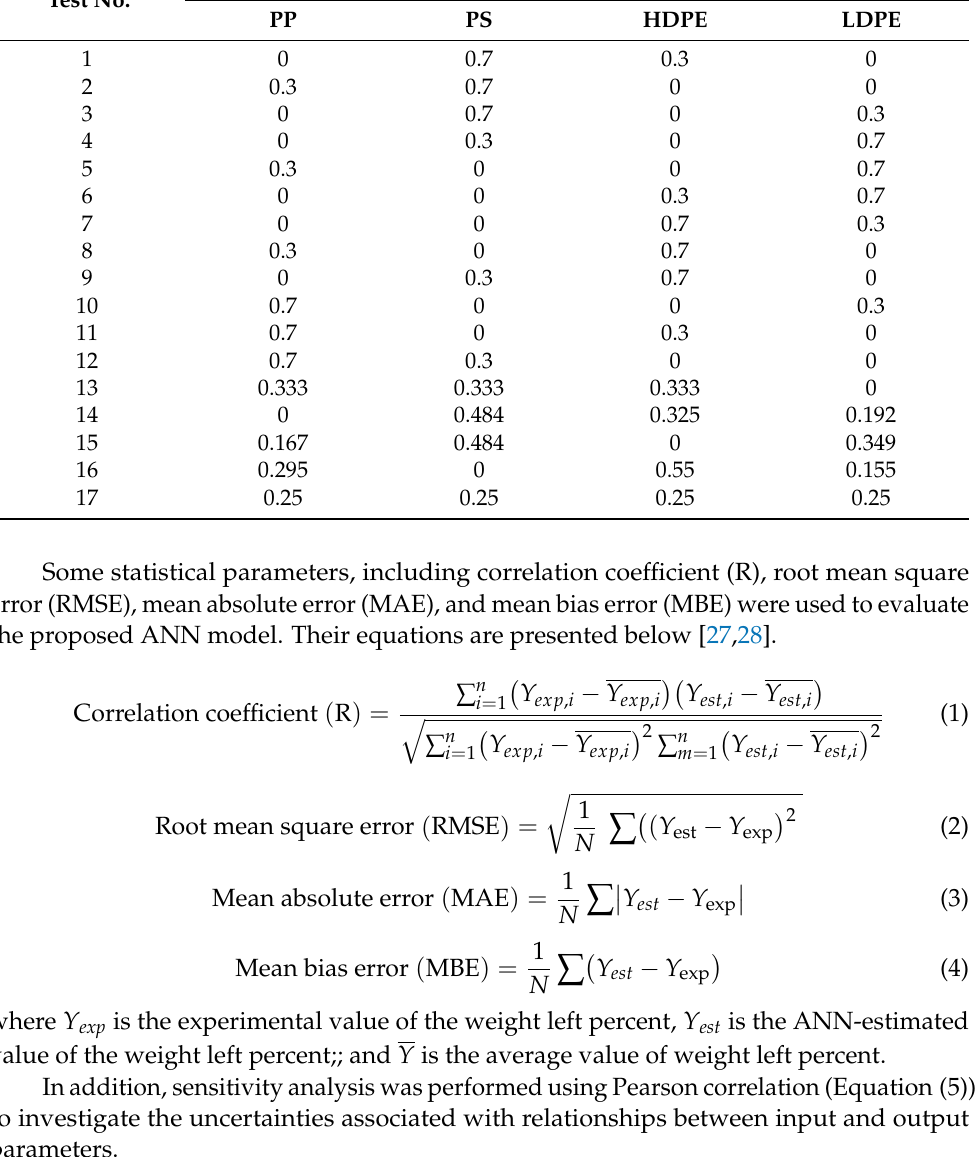
Table 2. Experimental matrix. Test